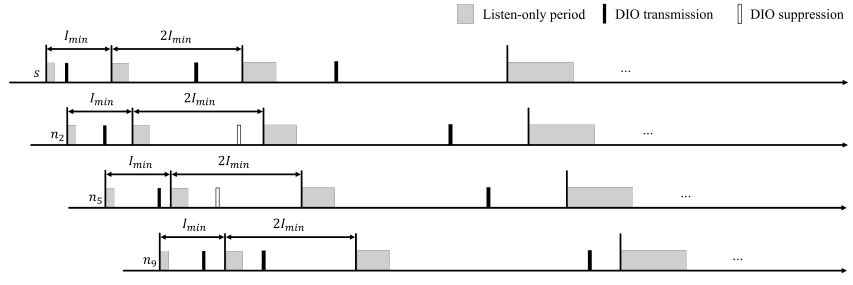
Figure 9. Adaptive trickle timer in 3D GVA-P2P-RPL.